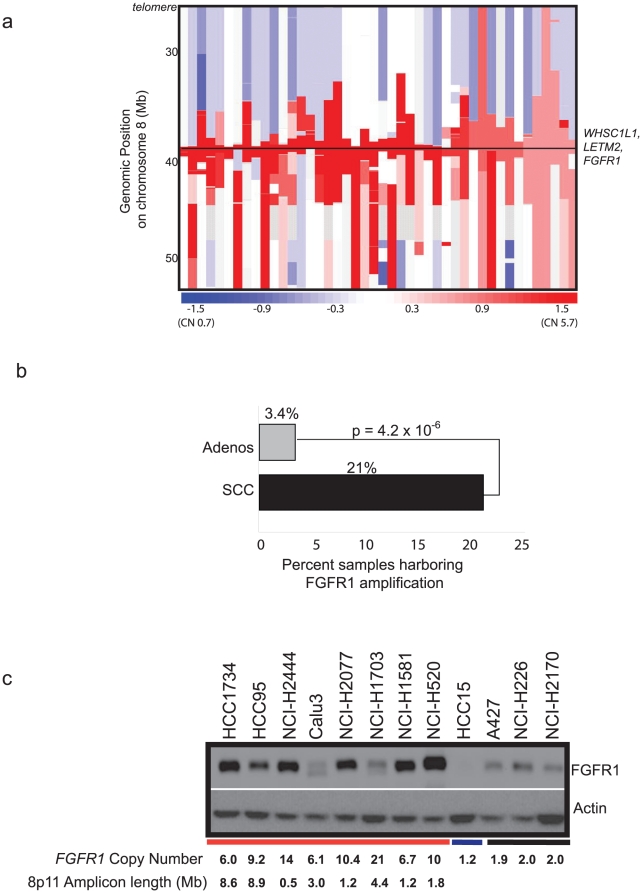
Amplifications of FGFR1 locus in NSCLC.(A) Copy number estimates at chromosome arm 8p11-12q for 44 NSCLC samples (columns; ordered by amplification of 8p11) having amplification greater than 3.25 copies (log2 ratio of 0.7) from a collection of 732 NSCLC primary samples and cell lines. The horizontal line indicates the region containing FGFR1, LETM2 and WHSC1L1 genes. The color scale ranges from blue (deletion) to red (amplification) with estimated copy numbers shown. Grey regions represent the absence of SNP copy number data. (B) Bar graph depicting percentages of samples harboring 8p11-12 amplification in lung adenocarcinomas (AC) and squamous cell carcinoma (SCC) demonstrates that FGFR1 amplification is observed in SCC at much higher frequency than AC. (C) FGFR1 expression (upper panel) shown in ten NSCLC cells; eight cell lines harboring FGFR1 amplification—HCC1734, HCC95, NCI-H2444, Calu3, NCI-H2077, NCI-H1703, NCI-H1581 and NCI-H520 (indicated by red horizontal bar below)—one NSCLC cell line harboring deletion of the region HCC15 (indicated by blue horizontal bar below)– and three NSCLC cells with no amplification—A427, NCI-H226, NCI-H2170 (indicated by black horizontal bar below)– using actin as a loading control (shown in lower panel). FGFR1 copy number status and 8p11-12 amplicon length determined by SNP array is indicated below cells harboring amplification. Of note, NCI-H2077 and NCI-1581 were found to be genotypically identical by fingerprinting analysis.